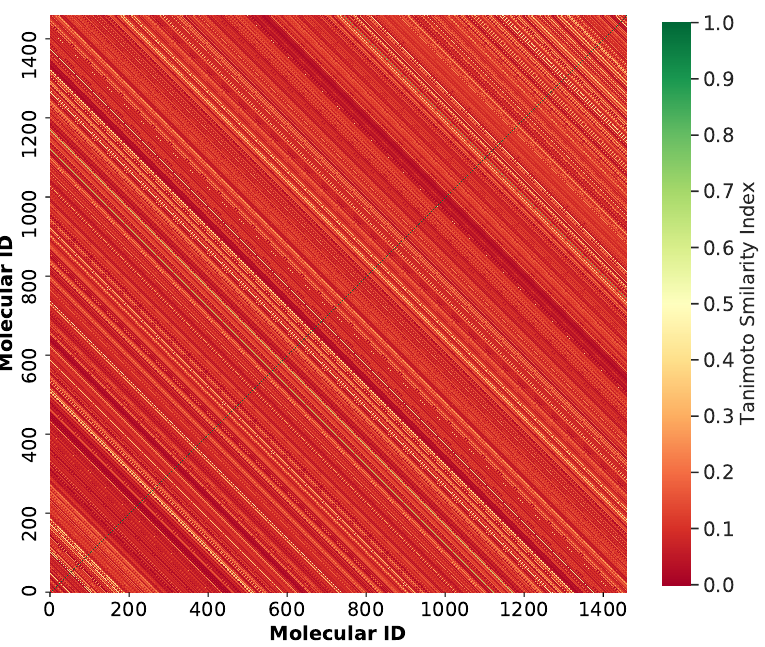
Figure 4. Heat map showing the molecular similarity of the molecules used in the entire dataset plotted by Tanimoto similarity index calculated using Morgan Fingerprints. The x -axis and y -axis represent the number of molecules used in the whole